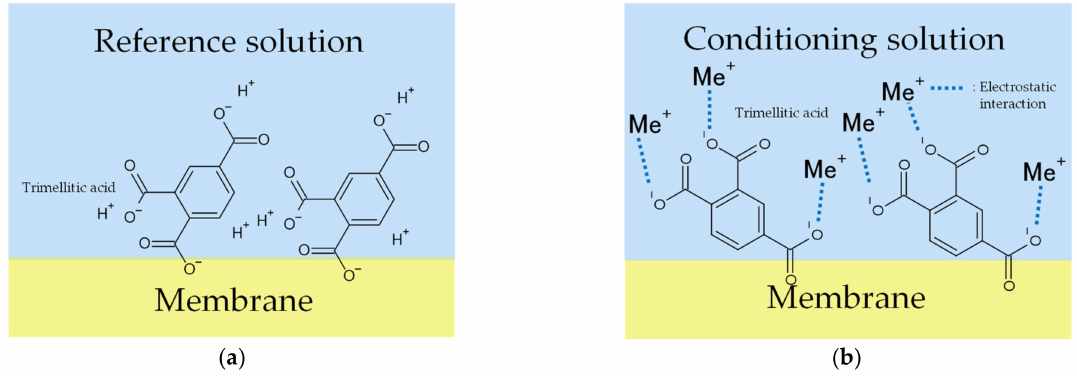
Figure 8. Models of response mechanism of the sweetness sensor with lipid/polymer membranes: ( a ) membrane in reference solution; ( b ) membrane in conditioning solution including univalent metal ions, such as K +